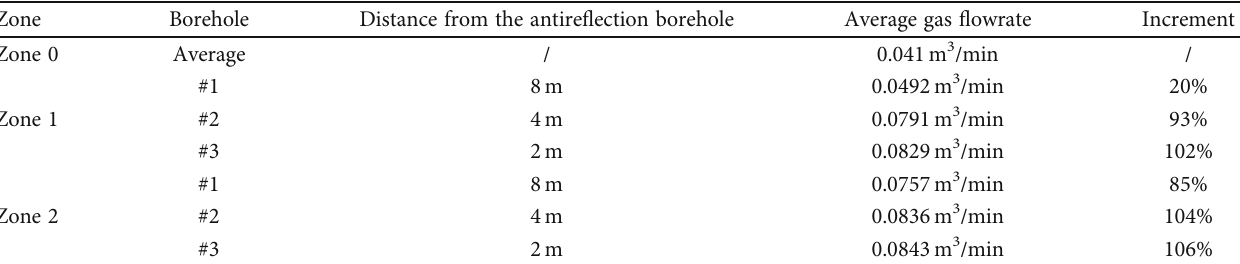
Table 2: Data analysis of gas fl owrate in borehole.